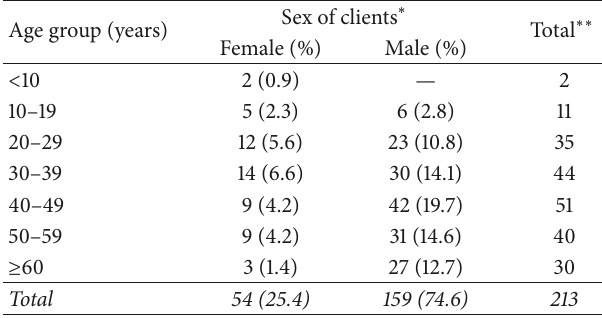
Table 2: Age and sex distribution of clients from 2012 to 2016. Age group (years)